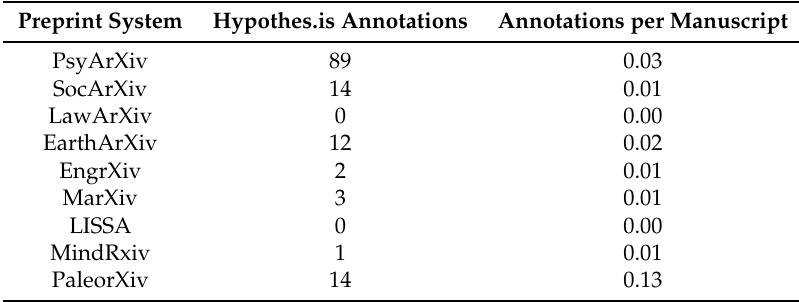
Table 6. Annotation counts for 9 COS